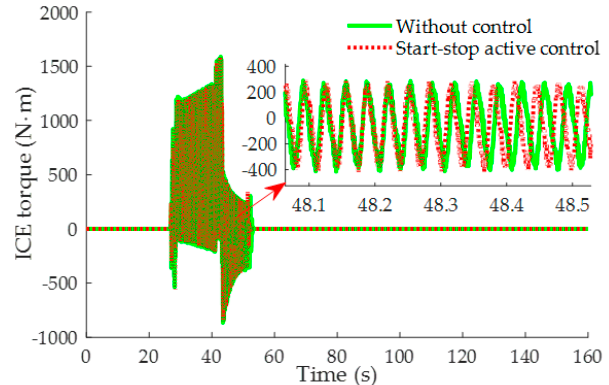
Appl. Sci. 2018 , 8 , x FOR PEER REVIEW